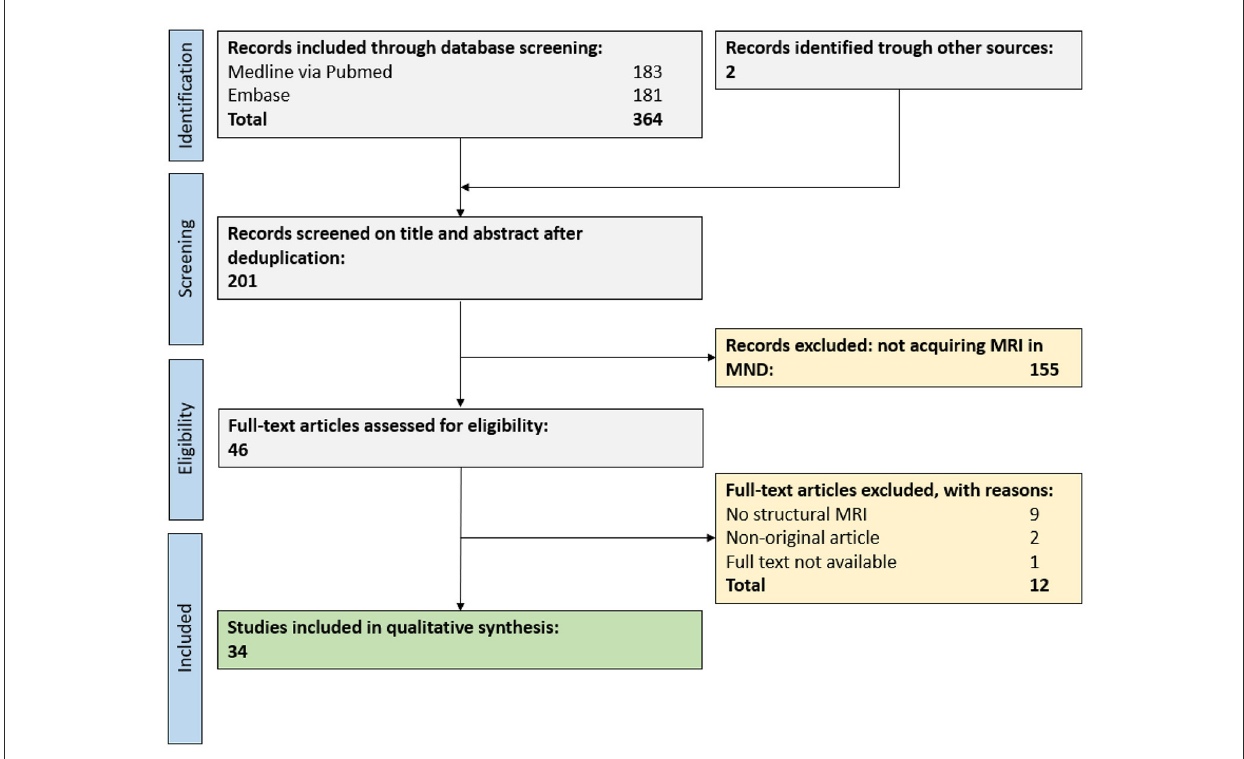
FIGURE2 PRISMA flow chart for study inclusion. A total of 34 publications were eligible for the qualitative synthesis. MND, motor neuron disease; MRI, magnetic resonance